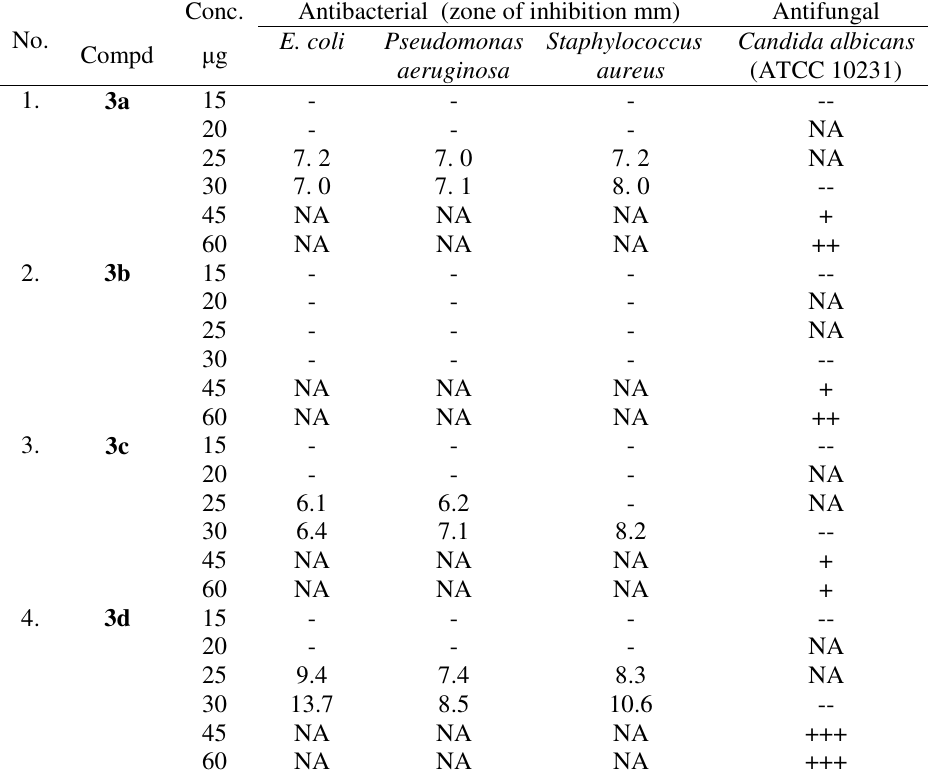
Table 2. Antimicrobial activity of compounds 3a-g .